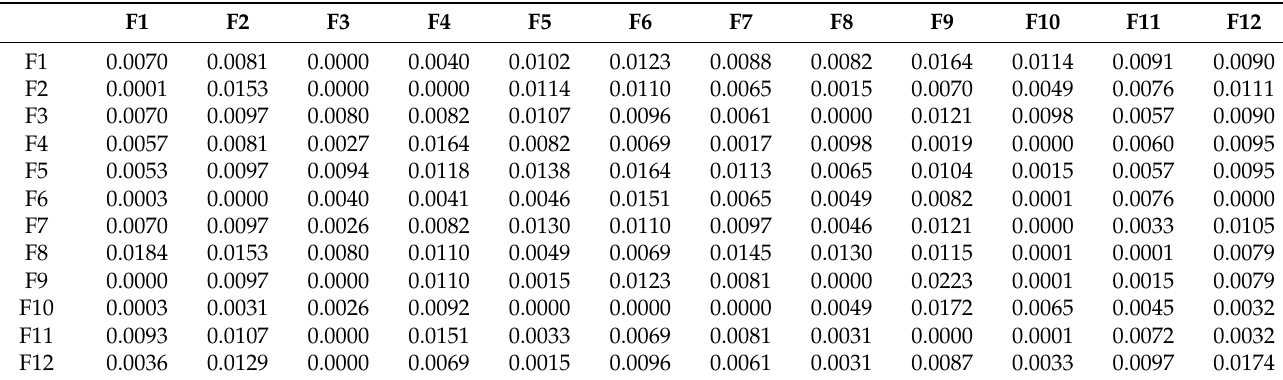
Table 10. The normalized crisp strength–influence